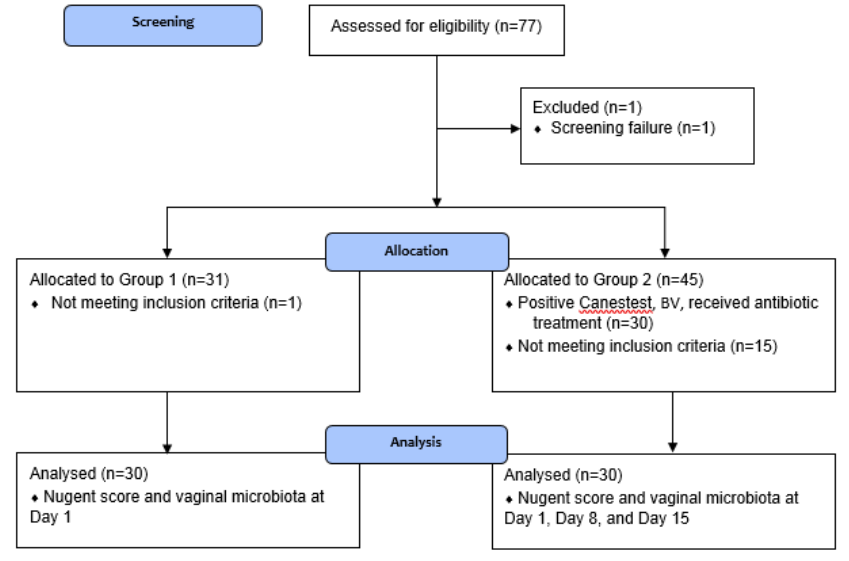
Figure 1. Flow of participants in the study.